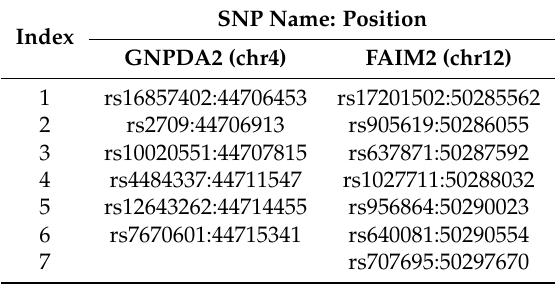
Table 1. Detailed information about GNPDA2 and FAIM2 used in a study of gene–gene interaction. Shown are the rsID (rs number used by researchers and databases to refer to specific SNPs)and physics position of each SNP on each